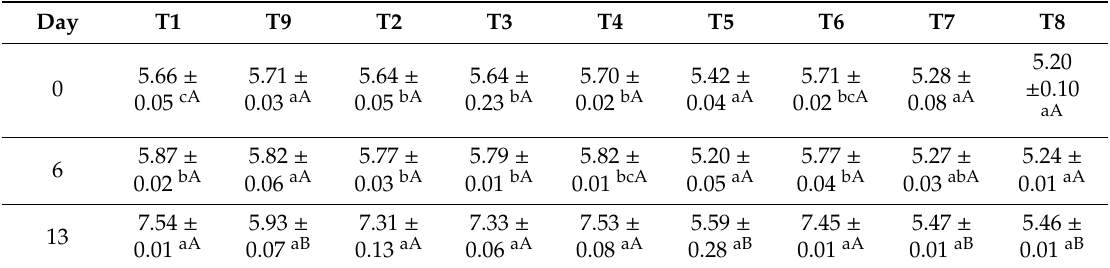
Table 6. pH values of the samples at di ff erent days of